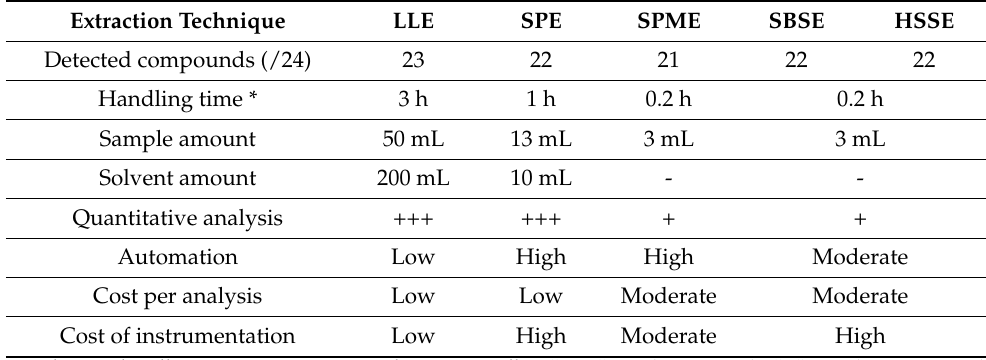
Table 2. Results obtained by applying different extraction techniques to the model mixture. Extraction